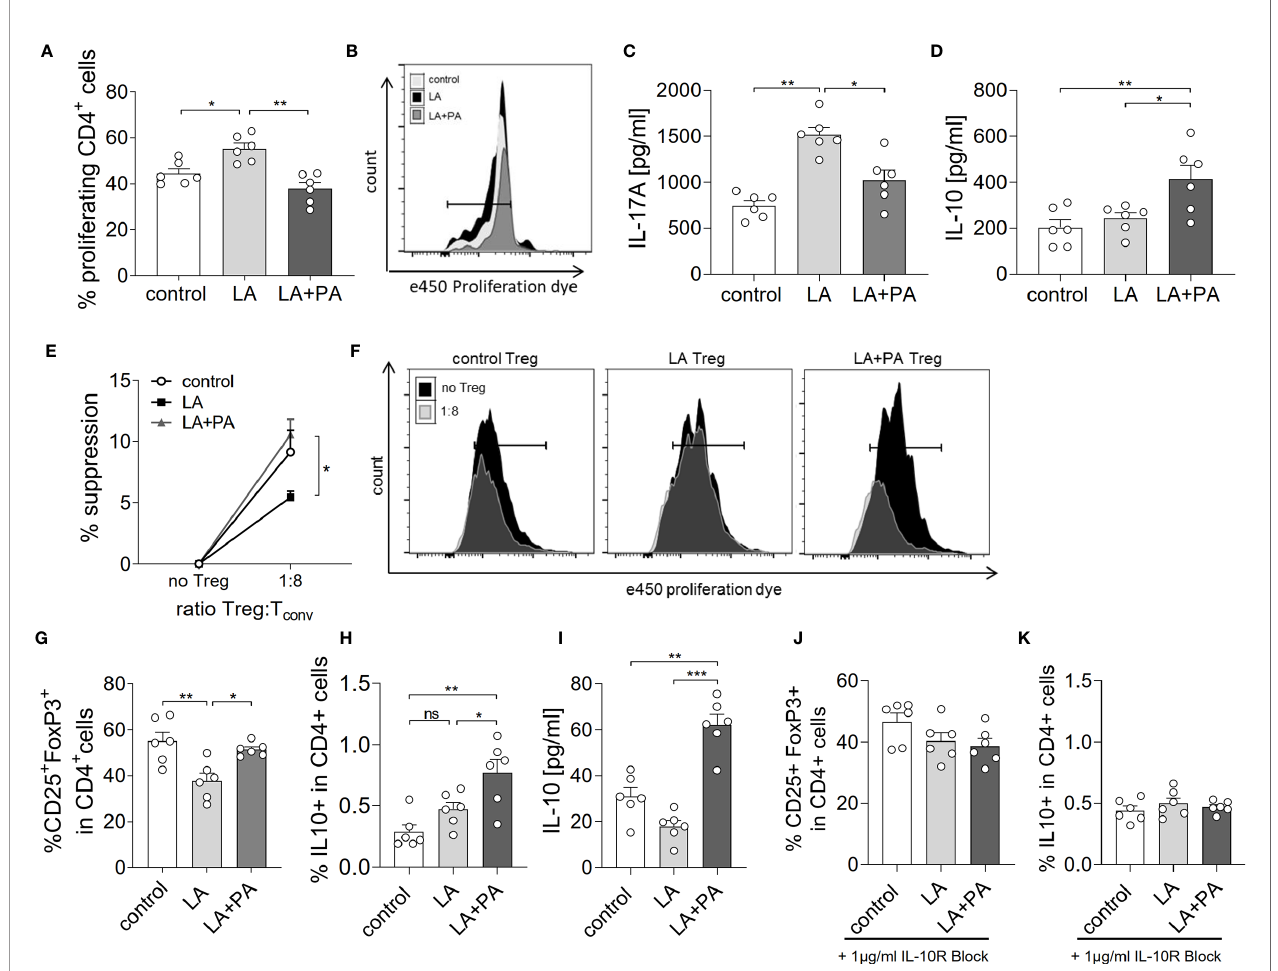
FIGURE 3 | PA reverts the deleterious effect of a LA-rich diet by increased IL-10 production and enhanced suppression capacity of Treg cells. Mice were fed a LA- rich diet or control-diet 4 weeks prior to immunization and were additionally treated with PA (LA+PA) or water (control; LA) by daily oral gavage starting from day 0. (A, B) Ex vivo proliferation assay of CD4+ T cells isolated from the spleen on day 10 of EAE. Isolated cells were re-stimulated with MOG 35-55 in vitro and proliferation was assessed by fl ow cytometry 72h later. (A) Quanti fi cation of proliferating cells from control, LA or LA+PA treated mice (n=6 per group). (B) Representative histograms of proliferating CD4+ T cells. (C, D) Splenic cells were isolated on day 10 of EAE and re-stimulated with MOG 35-55 in vitro for 48h. Quanti fi cation of (C) IL-17A and (D) IL-10 in cell culture supernatants analyzed by ELISA (n=6 per group). (E, F) Treg suppression assay of ex vivo obtained CD4+CD25+ splenic T cells isolated from control, LA or LA+PA treated mice on day 10 of EAE. CD4+CD25+ T cells were co-cultured with e450 labeled CD4+CD25- cells for 72h (n=5 per group). (F) Representative histograms of proliferating CD4+ cells co-cultured with or without Treg cells analyzed by fl ow cytometry. (G – I) Splenic naïve CD4+ T cells were treated with PBS (control), LA (250µM) or LA+PA (PA 150µM) under Treg polarizing conditions. Flow cytometry analysis of CD25+FoxP3+ cells (G) and IL10+FoxP3+ cells (H) in viable CD4+ cells was performed 96h later (n=6 from 2 independent experiments). (I) Quanti fi cation of IL-10 in cell culture supernatants of Treg differentiation assays analyzed by ELISA. (J, K) IL-10 signaling was blocked by the addition of an IL-10 receptor blocker (1µg/ml) to CD4+ T cell differentiation assay under Treg polarizing conditions (n=6 from two independent experiments). Flow cytometry analysis of CD25+FoxP3+ cells (J) and IL10+FoxP3+ cells (K) in viable CD4+ cells was performed 96h later (n=6 from 2 independent experiments). ns, not signi fi cant. *p<0.05, **p<0.01, ***p<0.001 using one-way ANOVA and Tukey ’ s posthoc